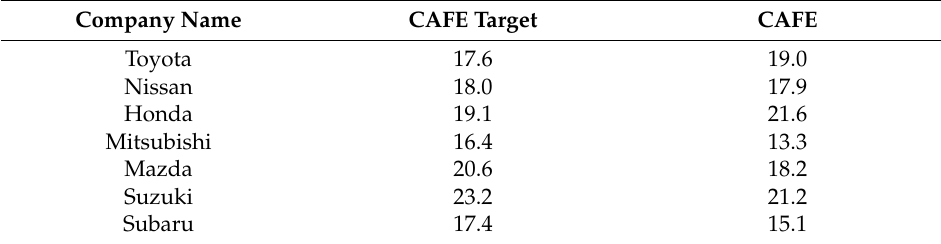
Table 2. CAFEs and CAFE targets of seven automobile manufacturers (unit: